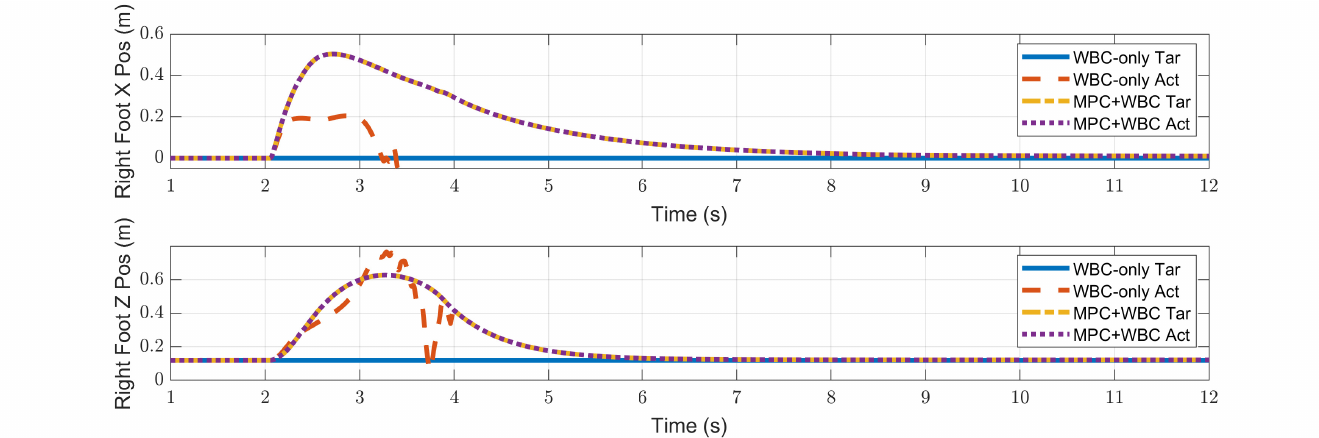
Figure 7. Swing foot position of the robot under the frontal impact of an 11 kg rigid ball.